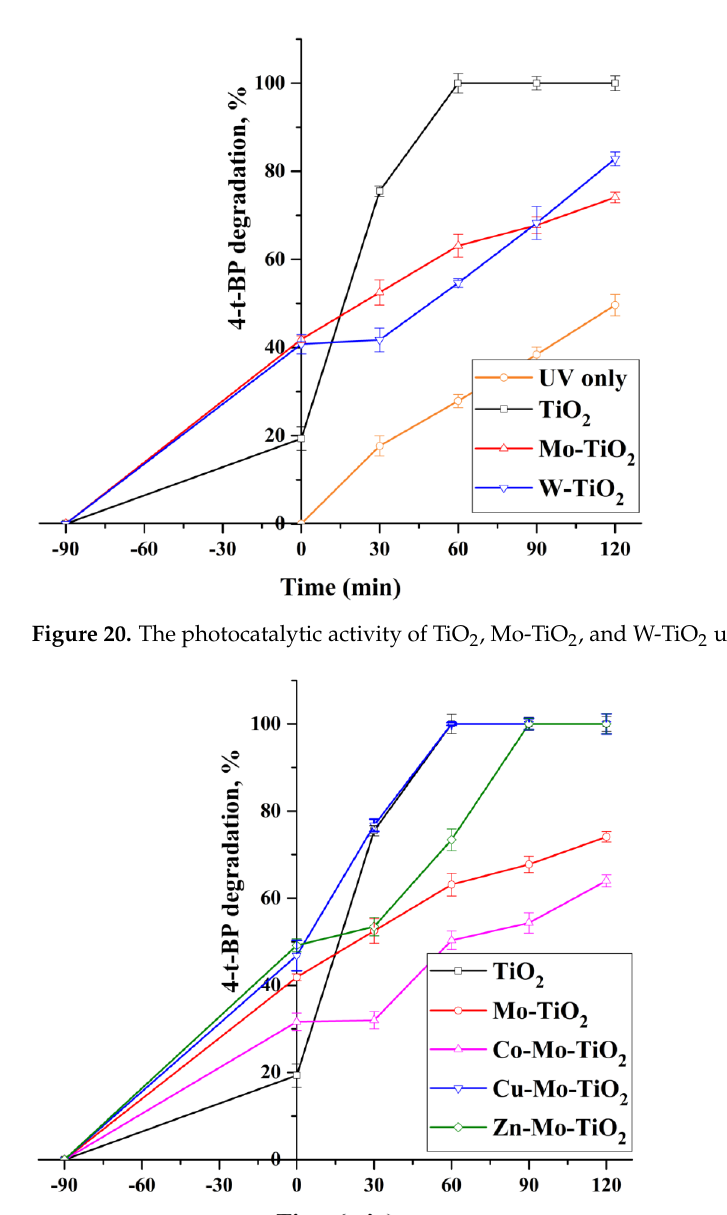
Figure 21. The photocatalytic activity of Mo ‐ TiO 2 , Co ‐ Mo ‐ TiO 2 , Cu ‐ Mo ‐ TiO 2 , and Zn ‐ Mo ‐ TiO 2 under UV irradiation.